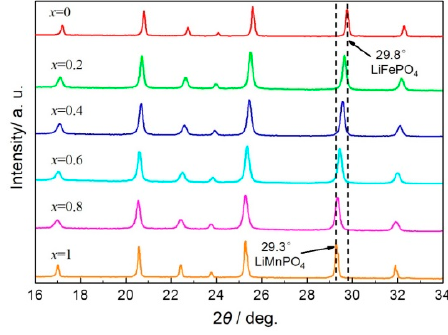
Figure 1. XRD patterns of LiMn x Fe 1 − x PO 4 /C composites.